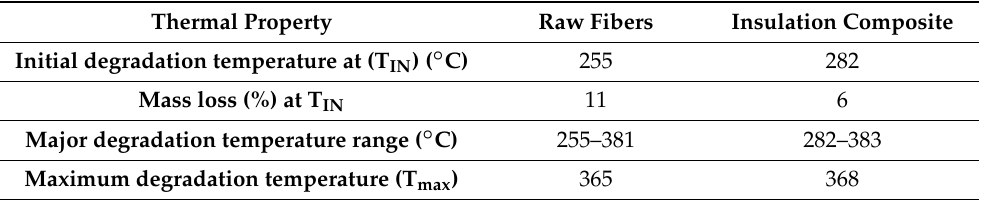
Figure 10. DTG of raw fibers and the insulation composite. Table 5. Thermal characteristics of raw fibers and insulation composite. Thermal Property